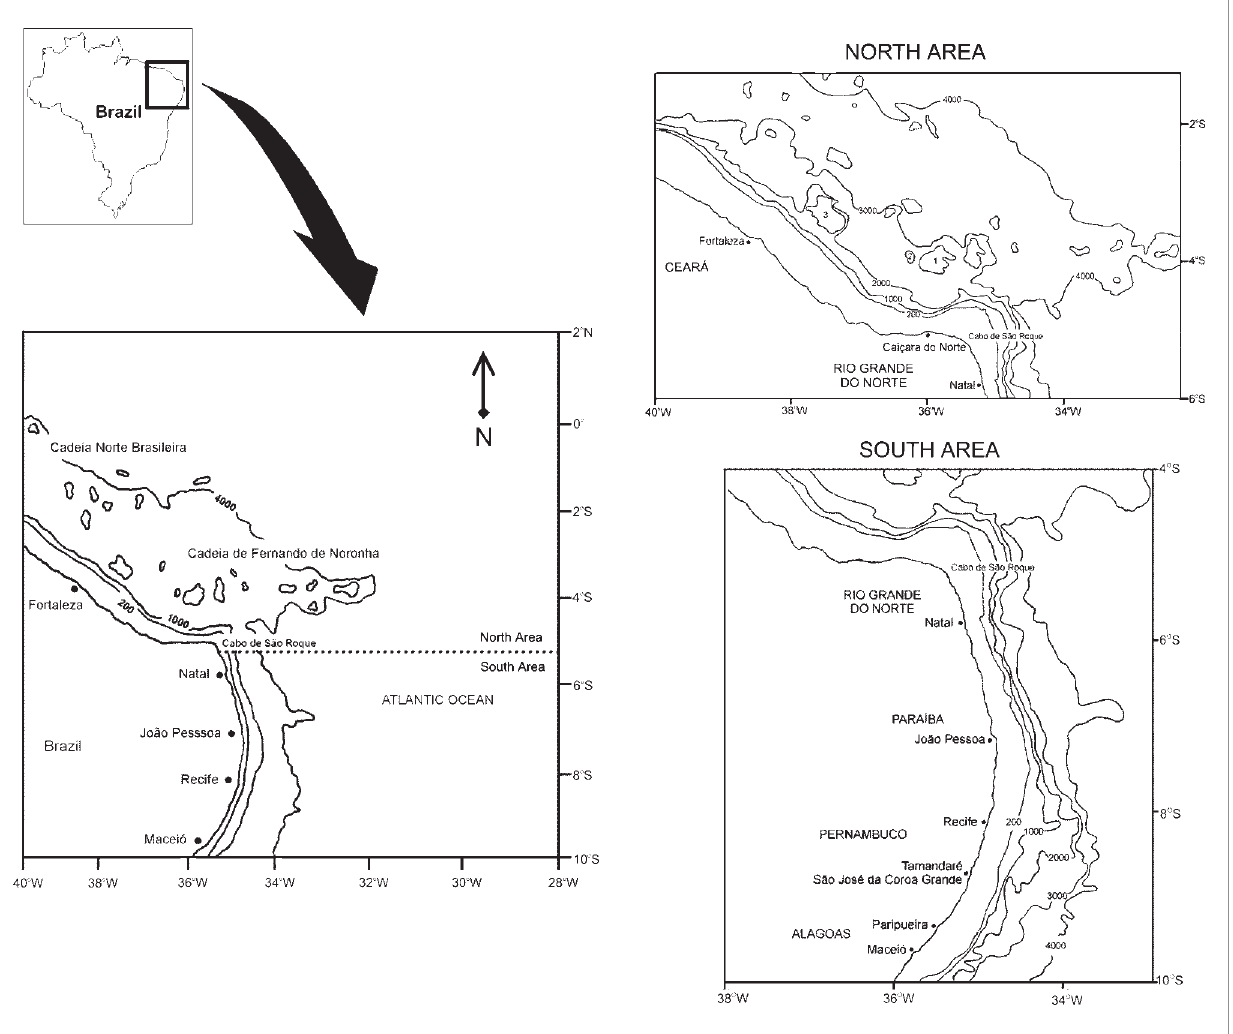
Fig. 1 . Sampling area (adapted from the Nautical Charts no. 50 and 60 of Diretoria de Hidrografia e Navegação – Brazilian Navy). Upper right: details of the North area, 1 – Sirius Bank, 2 – Guará Bank, 3 – Aracati Bank. Bottom right: details of the South